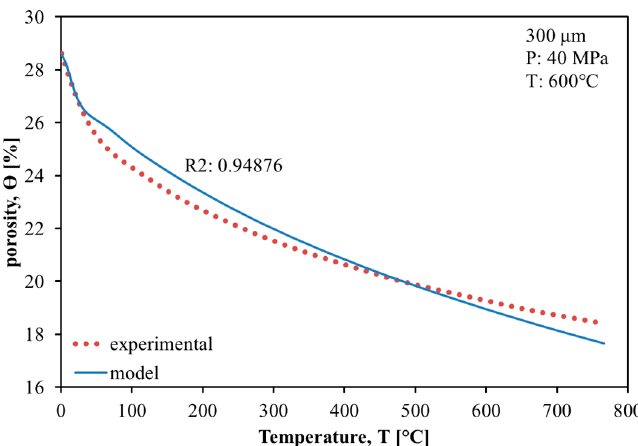
Figure 10. Fit of experimental data (dotted line) using the densification model (result shown with the solid line), R2—correlation coefficient. The results of all the cases analyzed are reported in Table 1.